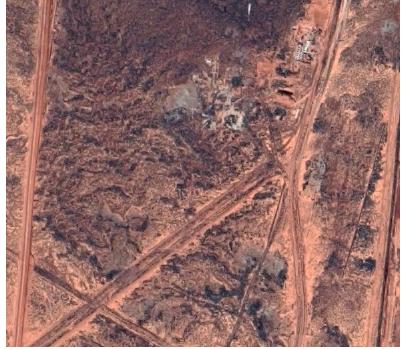
Figure 5. View of the field of Dataset 1.